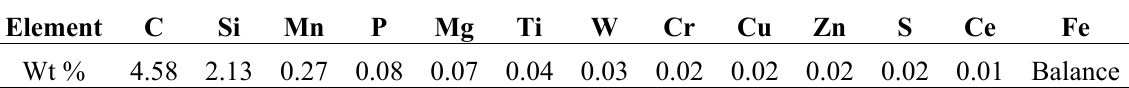
Table 3. Chemical compositions of the cast iron that has be employed in the present study.